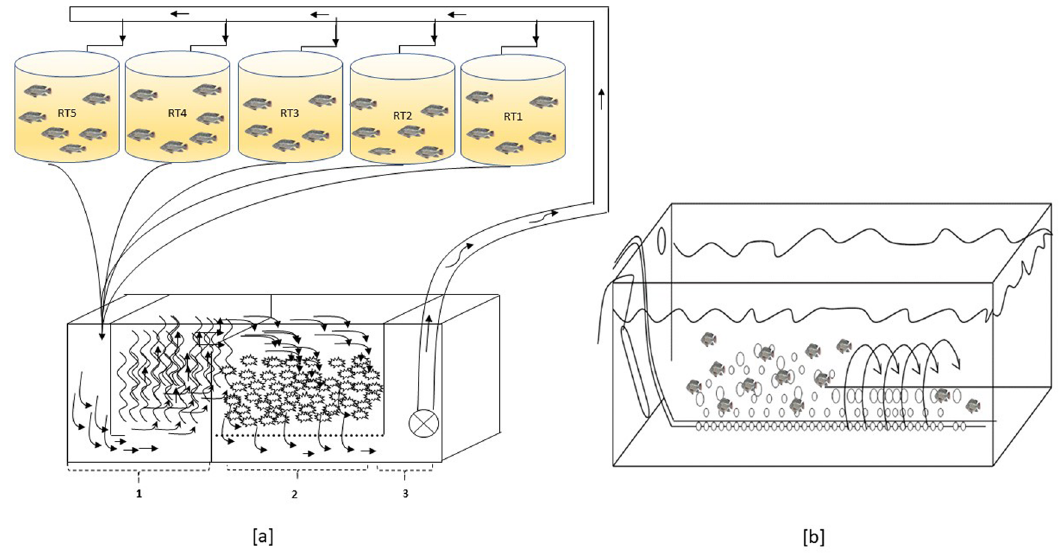
Figure 1: ( a ) Experiment design for recirculating aquaculture system: RT is rearing tanks, ( 1 ) sedimentation unit, ( 2 ) nitri fi cation unit, ( 3 ) sum unit; ( b ) 120 - L tank of